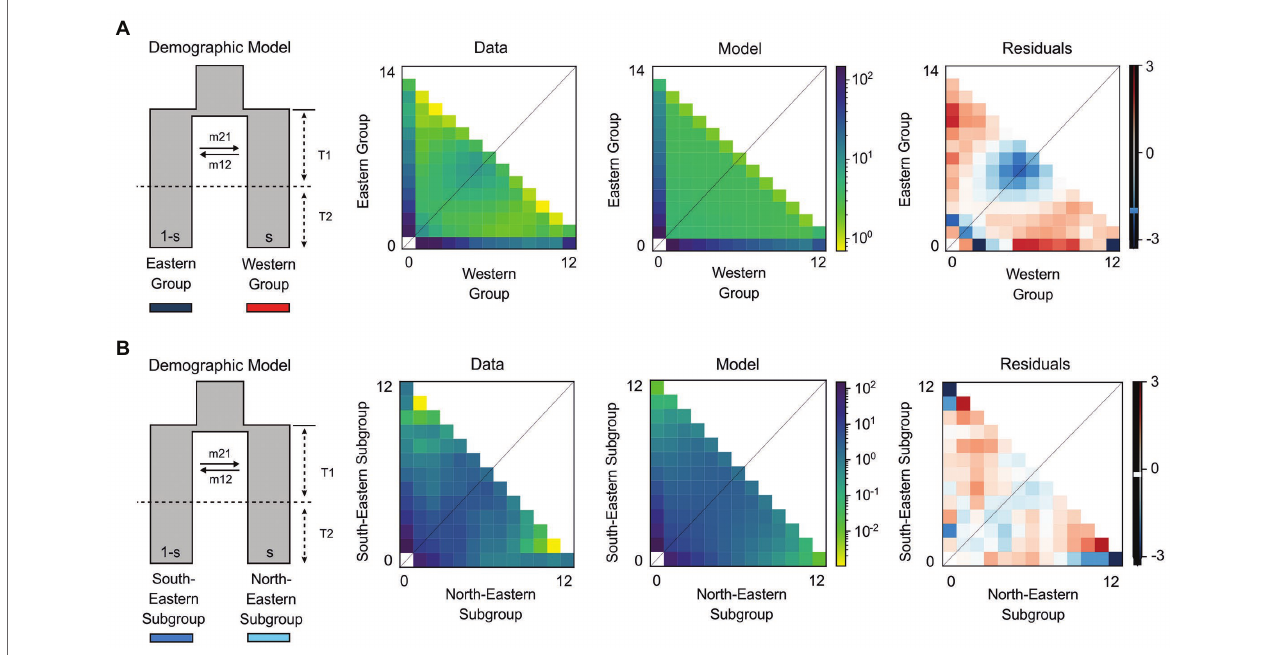
FIGURE 4 | The best demographic models for H. niger using two-dimensional joint site frequency spectrum (2D-JSFS) between population sets including (A) Eastern ( n = 14) and Western ( n = 12) Group and (B) South-Eastern ( n = 12) and North-Eastern Subgroup ( n = 12). A visual representation of the best-fit model is depicted, along with comparisons of the 2D-JSFS for data, model, and resulting residuals. For both comparisons, the best-fit model represents the scenario where the ancestral population split due to vicariance. This was first followed by period T1 of continuous asymmetric migration between newly established populations, and then by period T2 of isolation. Additional models and parameter values are provided in Table 2 and Supplementary Table 3 .